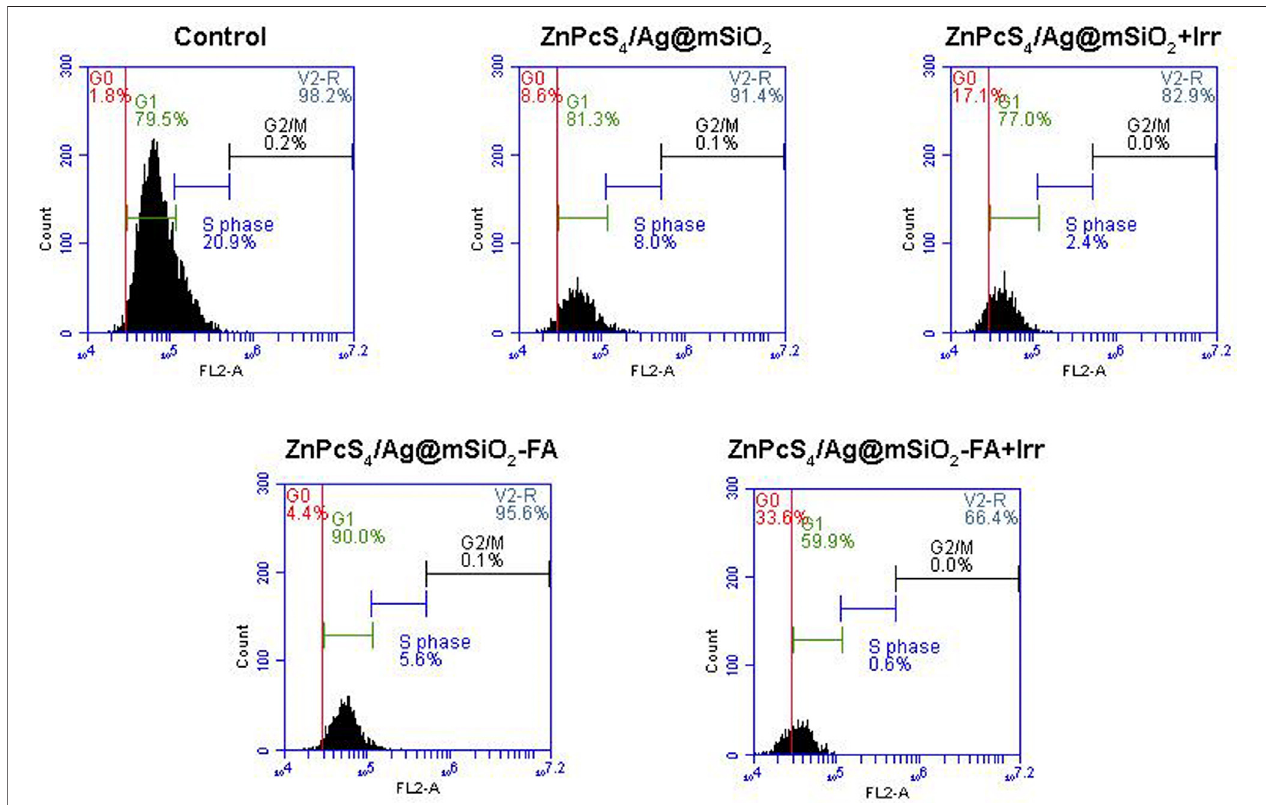
FIGURE 7 | Cell cycle analysis via DNA quanti fi cation using fl ow cytometry on Caco-2 cells with passive and actively targeted NCs under an equivalent concentration of ZnPcS 4 and 10 J/cm 2 fl